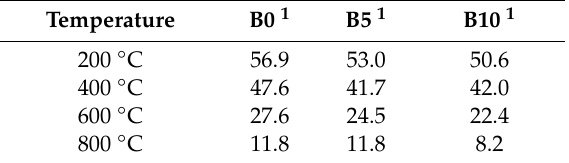
Table 6. Average compressive strength fcm (MPa) of heated concrete composite after 180 days.